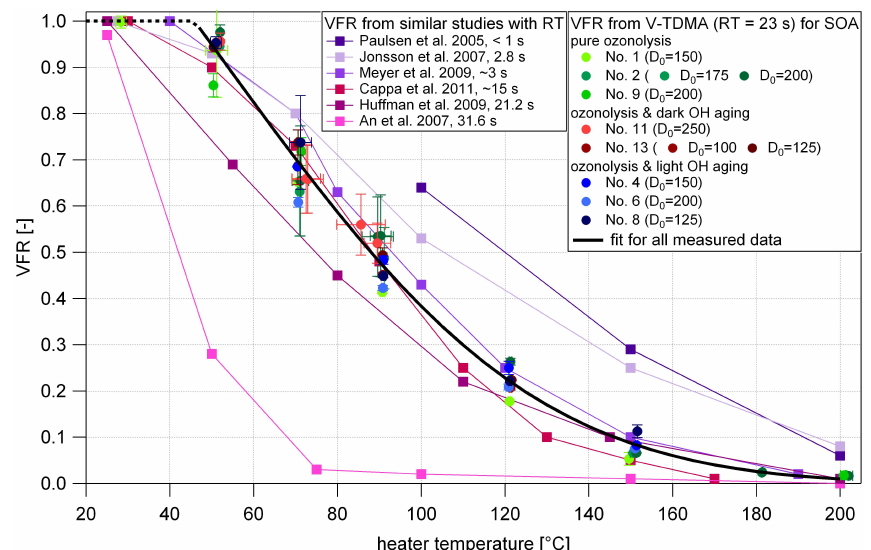
Fig. 4. Mean VFR measured for SOA from three different experiment types, distinguished with greenish, reddish and bluish color, at various heater temperatures with error bars representing the standard deviation of VFR and temperature of multiple measurements during the experiment (circles). Literature data (squares) from similar SOA studies were added for comparison. The black solid line represents a fit through all measured data of this